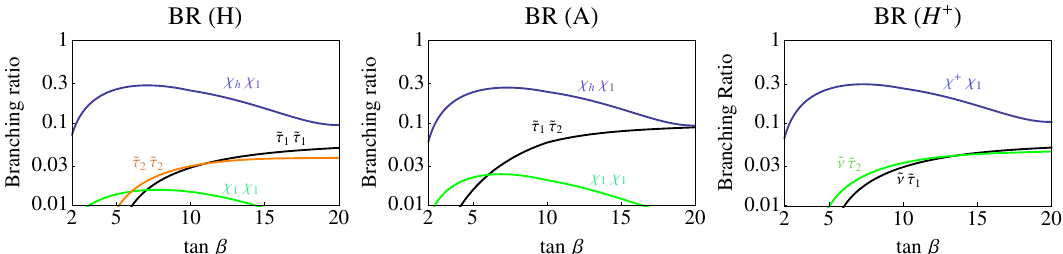
Figure 2 . Branching ratios of the heavy Higgs bosons into the various electroweak states, as calculated with FeynHiggs 2.10.2 [55]. For these plots, we set m A = 800 GeV, m ~ (cid:28) 350 GeV, M 1 =150 GeV, A (cid:28) = 1 TeV, and all other dimensionful parameters to 2 TeV. (cid:31) h (cid:31) 1